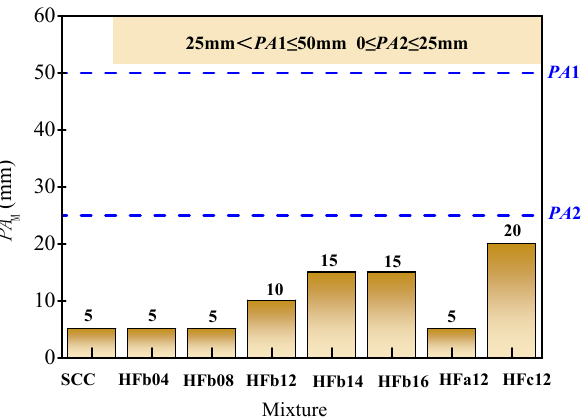
Figure 6. Passing ability of fresh mixtures tested by using modified rebar spacing of the J-ring. Table 4. The height difference of fresh concrete between inside and outside of the J-ring.